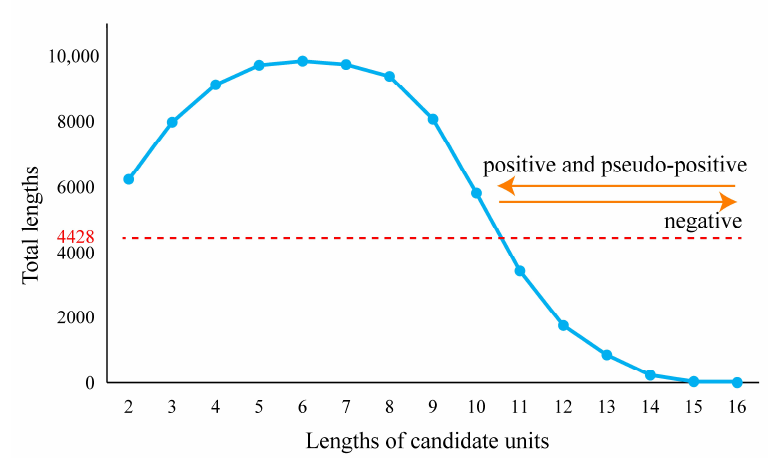
Figure 3. The total lengths of candidate units. The total length is equal to the length of the candidate unit multiplied by the number of candidate units. The total length of ancestral 16S, 5S, and 23S rRNA sequences of LUCA was 4428 nucleotides (marked by red line).